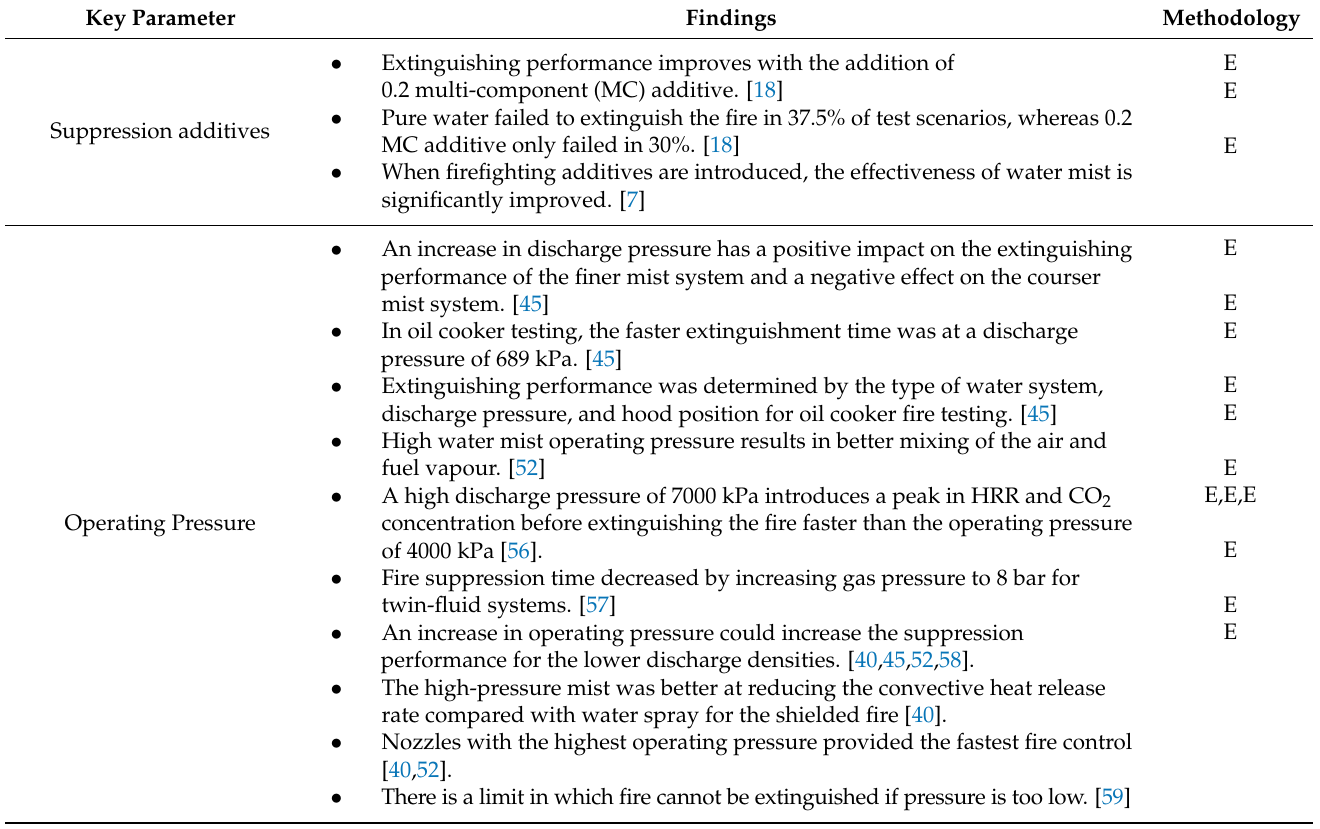
Table 2. Experimental and numerical research on water mist suppression. Findings